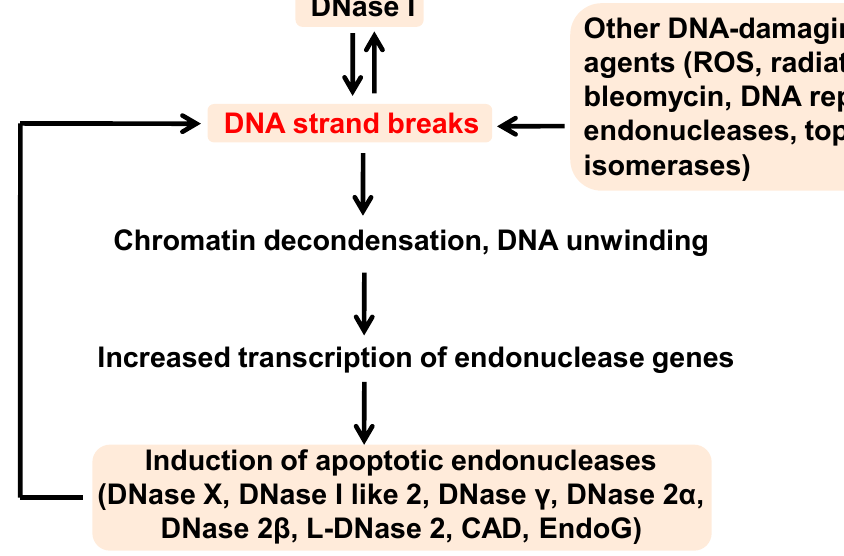
Figure 8. Hypothetical scheme of apoptotic endonuclease network.